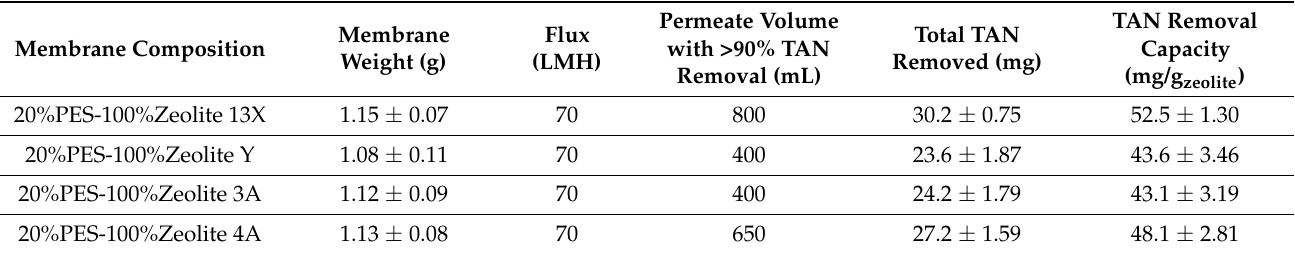
Figure 7. The percentage of TAN removal as a function of the filtrate collected for mixed matrix membranes incorporating different zeolite particles of 13X, 3A, 4A, and Y. The membranes have the same mass composition of 20%PES-100% Zeolite. Table 3. TAN removal capacities for mixed-matrix membranes incorporating different zeolite types with the same mass composition and the feed concentration of 6 ppm. The weight of the membrane, and the filtrate volume with more than 90% TAN removal, the total amount of TAN removed are also